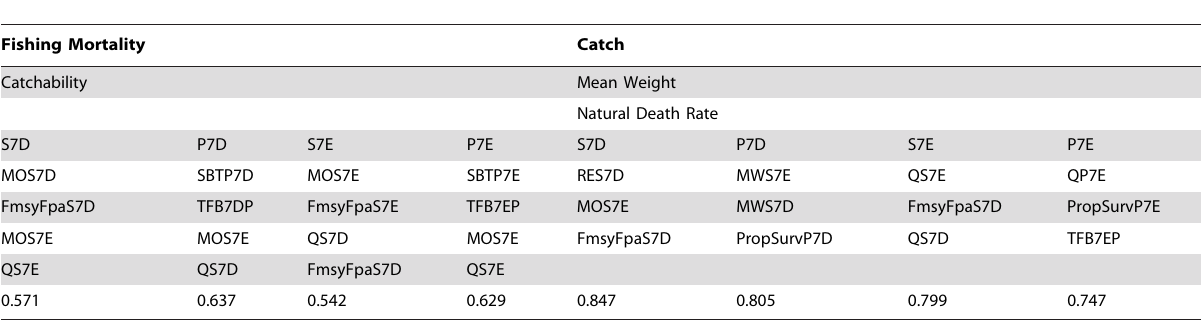
Table 6. Input parameters most impacting output variables